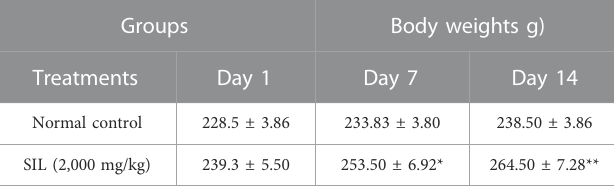
TABLE 1 Estimation of mice body weights during acute oral toxicity study.